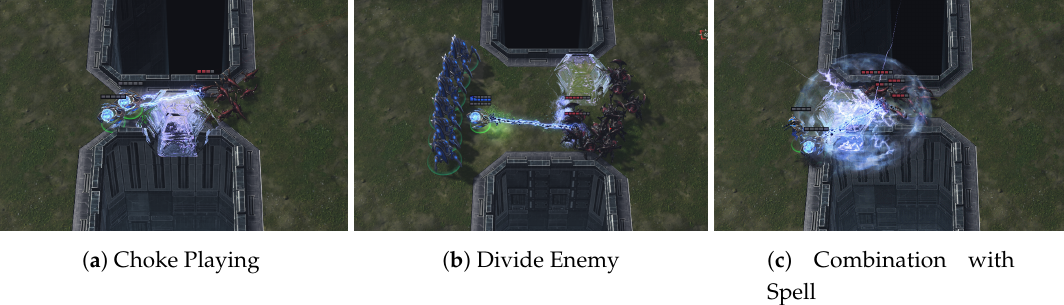
Figure 5. Screenshot images of Minigame combat after